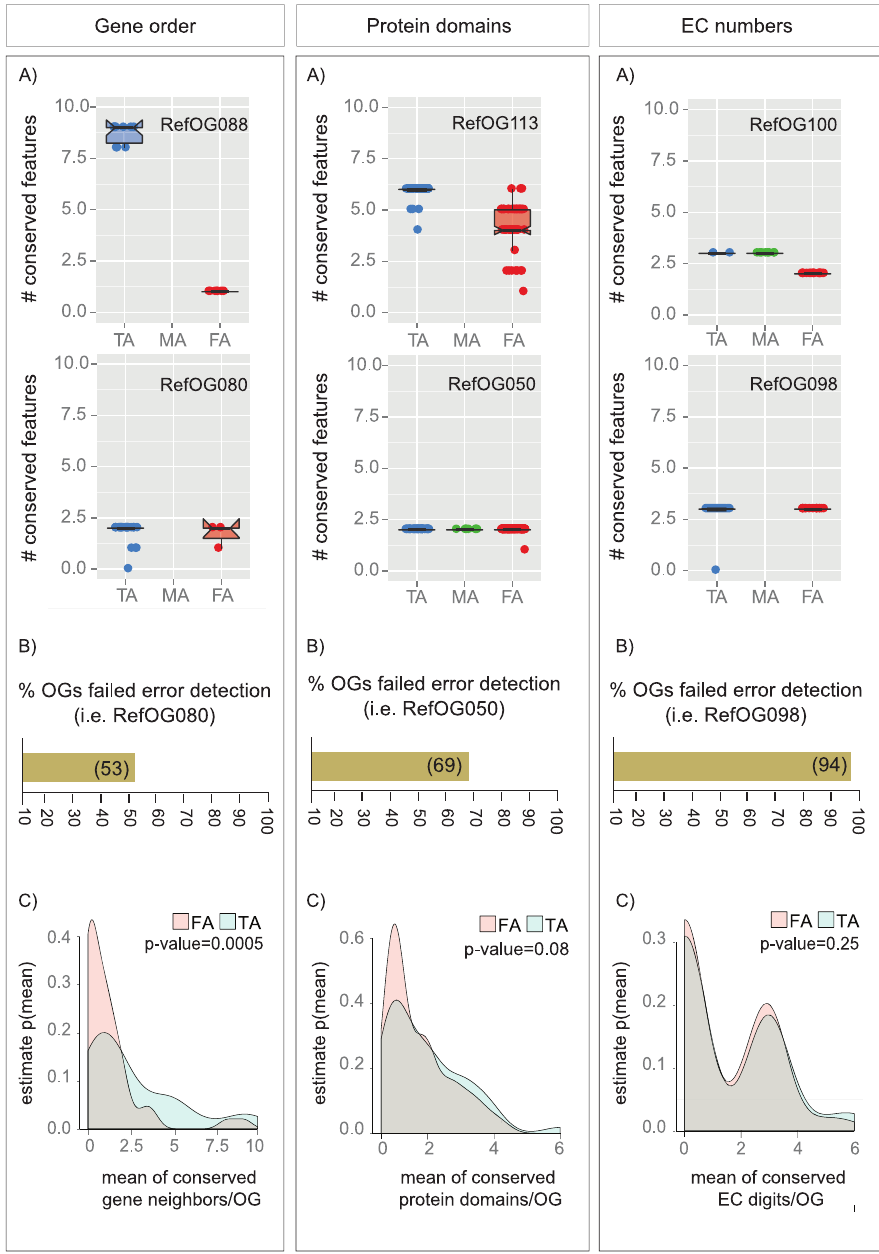
Figure 3. Function-based benchmark tests do not separate between false- and true- assignments. Consensus functional annotations were determined based on (i) gene order (number of neighbor gene families that are conserved across RefOG members) , (ii) protein domain content (number of protein domains that are conserved across RefOG members) and (iii) enzymatic activity (number of EC digits that are conserved across RefOG members) for every RefOG (Material and Methods). A) The distribution of conserved features across true-, missing- and false assignments for each family are illustrated with boxplots. The upper and lower boxplot panels exemplify families where the functional feature does or does not discriminate, respectively, false and true assignment. B) Bar plots show the number of orthologous groups that would be classified as ‘‘accurately inferred’’ using function-based tests. C) Density plots illustrate the probability to discriminate the true-, missing- and false-assignments for every function-based test (density of mean number of the conserved features for every assignment category/RefOG). The data for all 49 RefOGs is shown in the Figures S1-S3 in File S1 and Tables S2-S4 in Data S1.